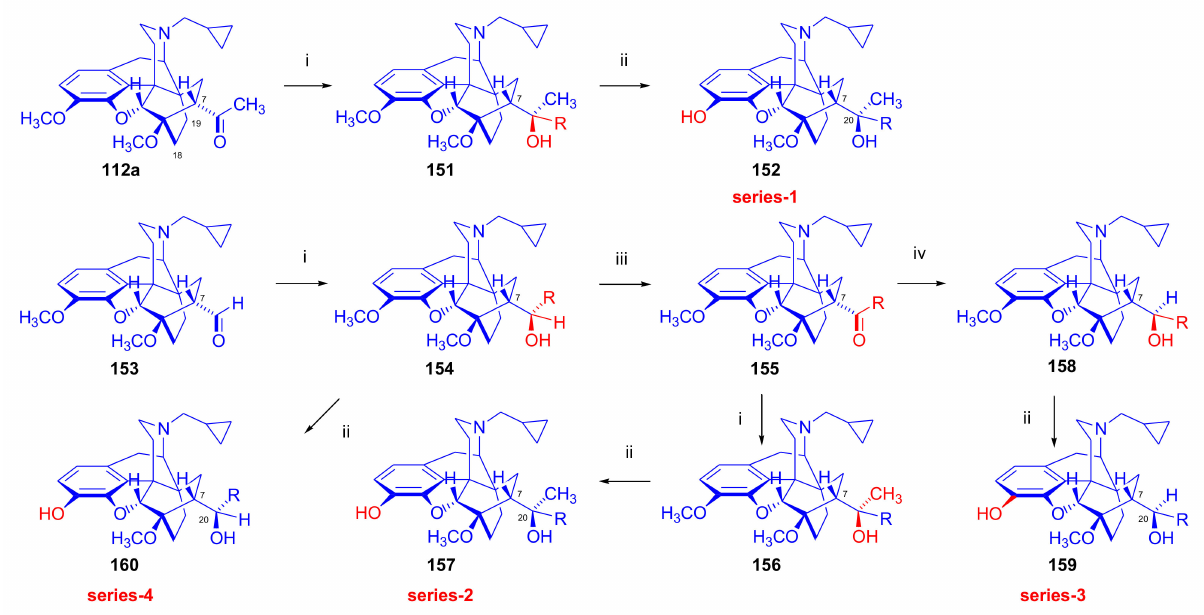
Figure 41. Synthesis of 20-substituted tertiary and secondary alcohol analogues of